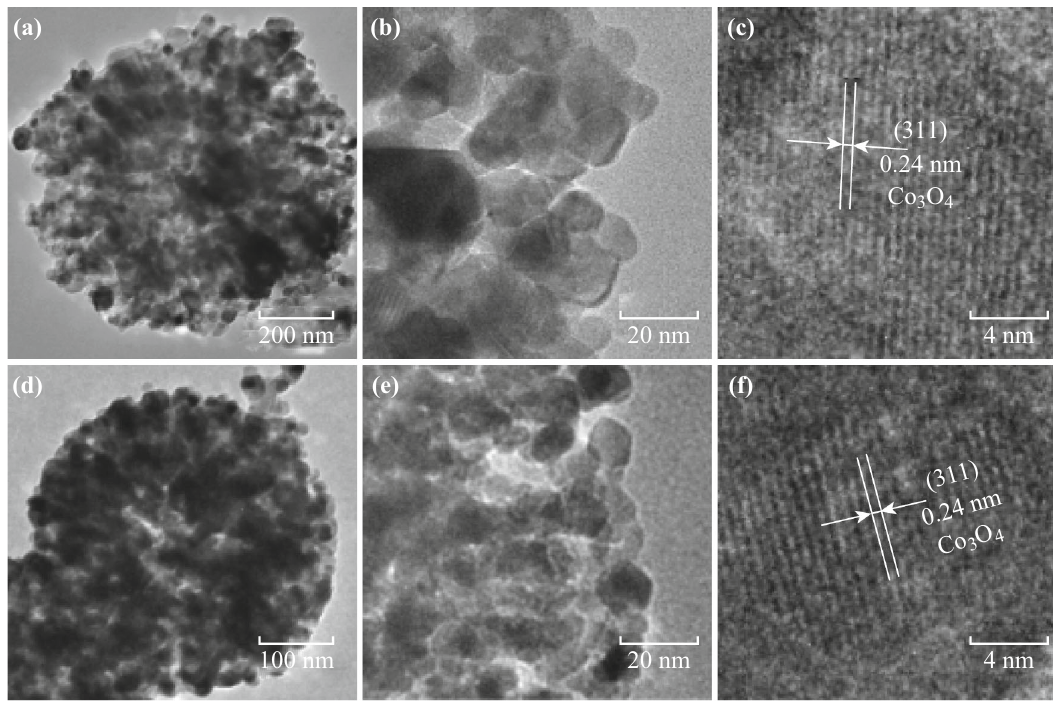
Fig. 2 TEM images of a–c M-Co 3 O 4 /NPC and d–f H-Co 3 O 4 /NPC